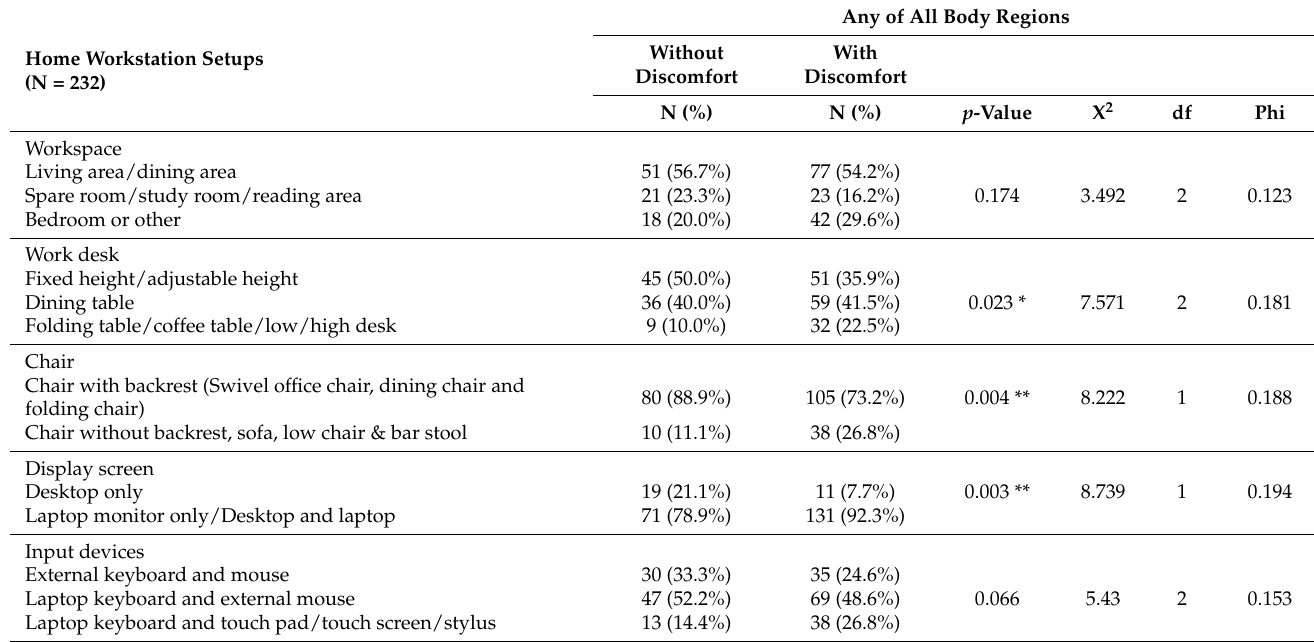
Table A6. The association between the home workstation setups and with/without musculoskeletal discomfort of any of all body regions.